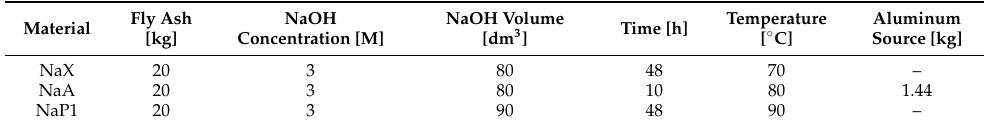
Table 2. Conditions applied for the zeolites